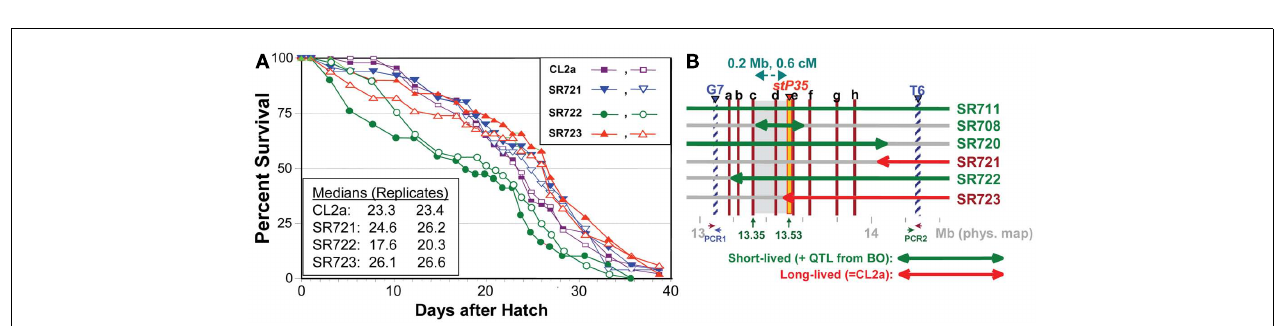
FIGURE 5 | Sequencing data for single-nucleotide polymorphisms that distinguish between parental strains Bergerac-BO and CL2a. SNPs are shown only if informative to determine the parental origin of that site in